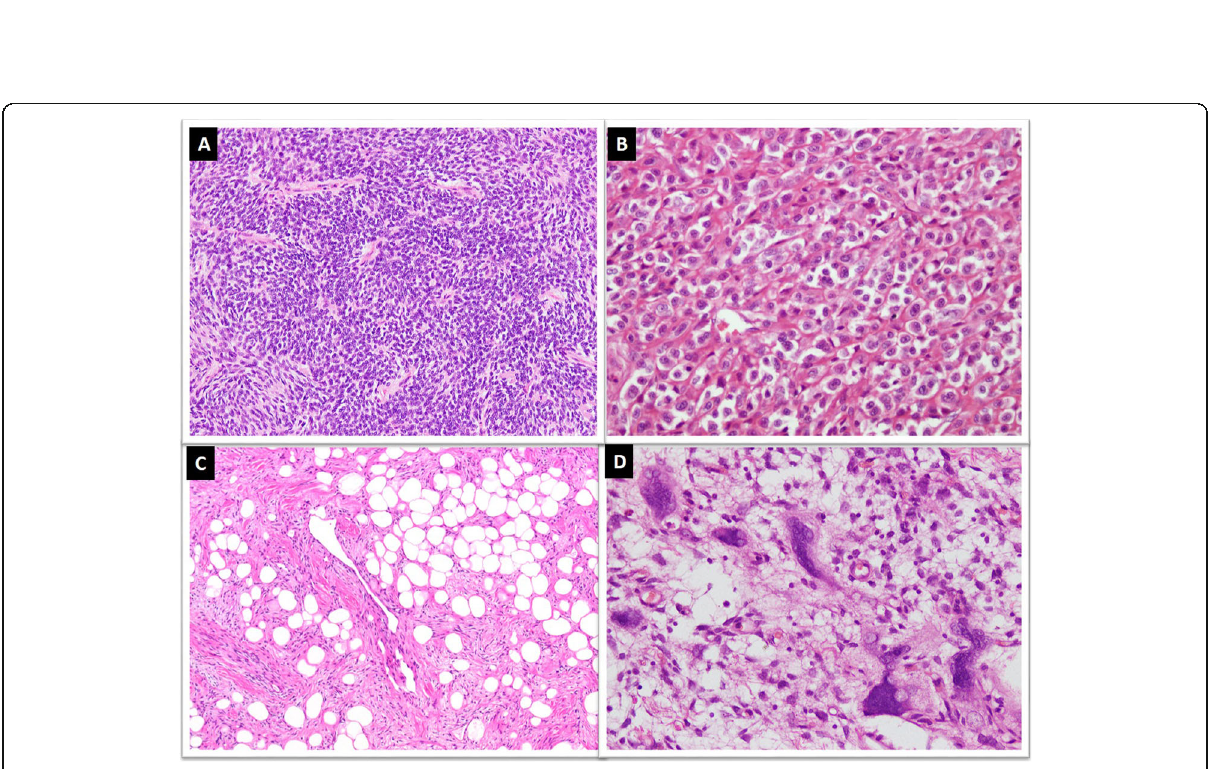
Fig. 4 a . Markedly cellular tumor showing sheets of small sized cells with hyperchromasia, b . Tumor cells exhibiting round cell morphology, c . Lipomatous SFT composed of mature adipocyte intermixed with tumor cells, d . Giant cell SFT exhibiting multinucleated giant cells focally lining pseudovascular